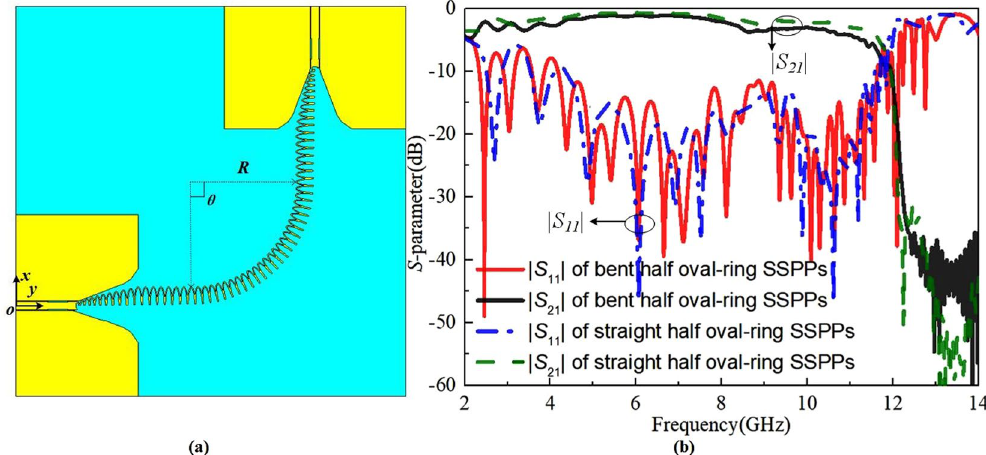
Figure 4. ( a ) The bent half oval-ring SSPPs waveguide, in which θ = 90°, R = 34 mm and s2_L = 5.5 mm. ( b ) The simulated | S 11 | and | S 21 | magnitudes of the bent half oval-ring SSPPs waveguide.